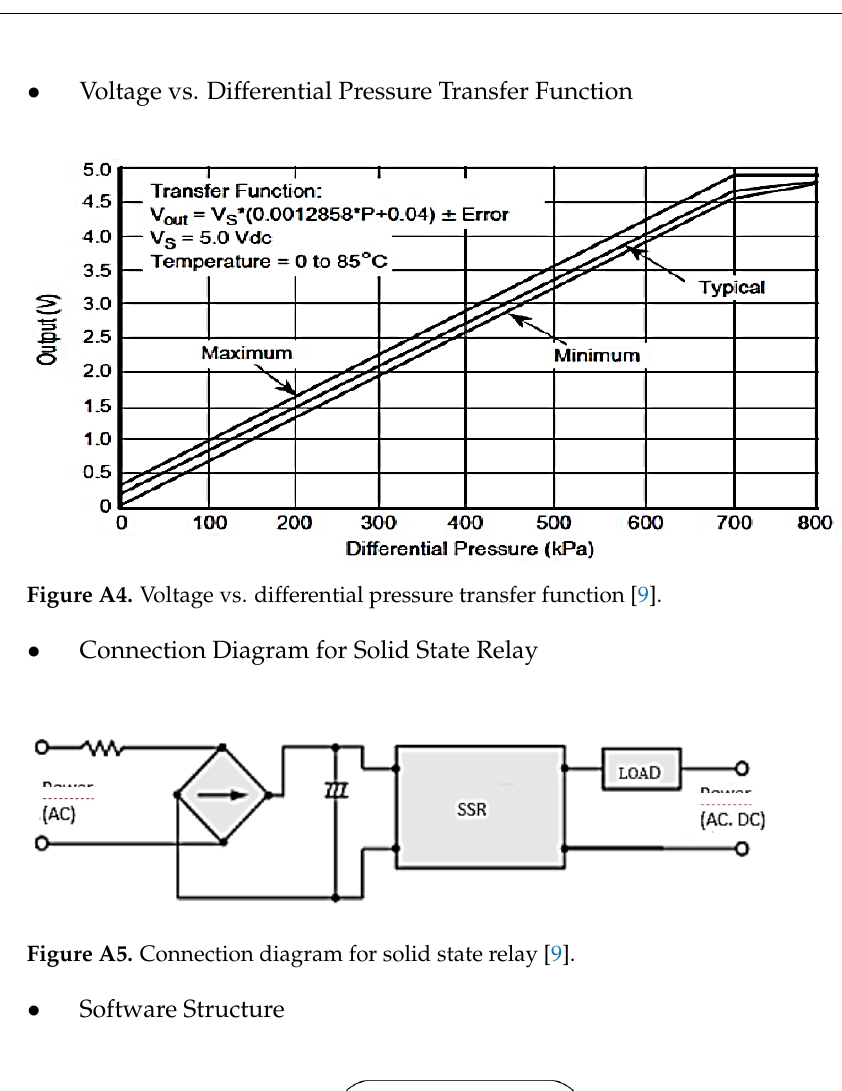
Figure A3. Conditioning capacitors for the pressure sensor [9].